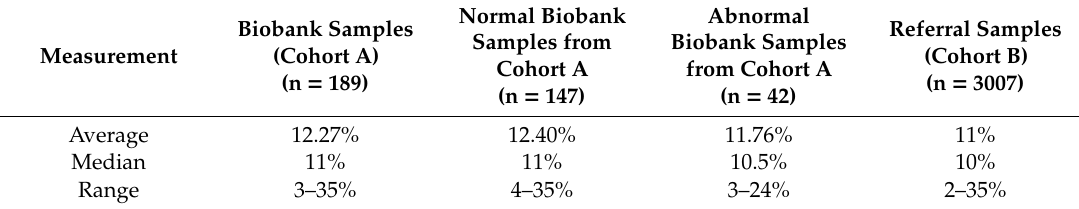
Table 6. Fetal fractions of the biobank and referral